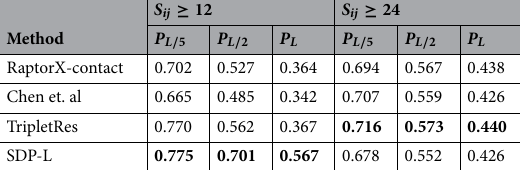
Table 6. Precision values for top contacts on CASP13.31 targets.